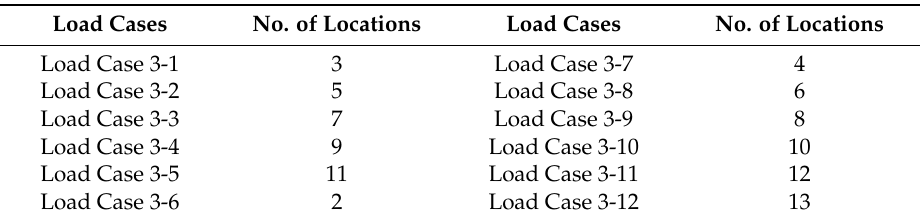
Table 10. Number of locations excited in Load Case 3-1 to